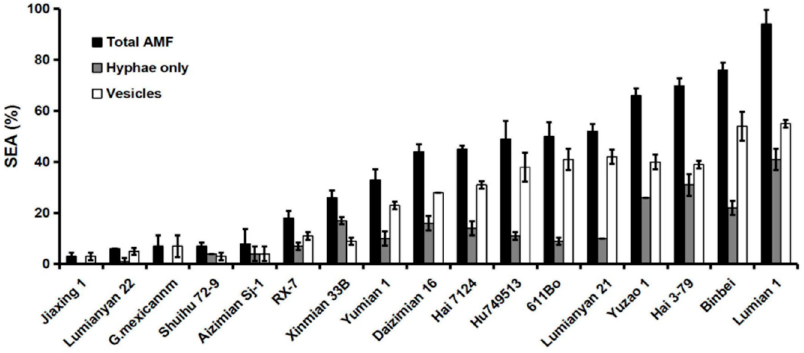
Figure 1. Evaluation of the symbiotic efficiency of AMF (SEA) among seventeen cotton cultivars. One hundred 1-cm root fragments were investigated from each plant after 40 days of growth with Rhizophagus irregularis CD1 during greenhouse conditions. The parameters Hyphae only (%), Vesicles (%), and Total AMF (%) denote the frequency of internal hyphae (without vesicles), vesicles, and total mycorrhizal colonization, respectively. The experiment was repeated twice under greenhouse conditions. Error bars represent ± SD.